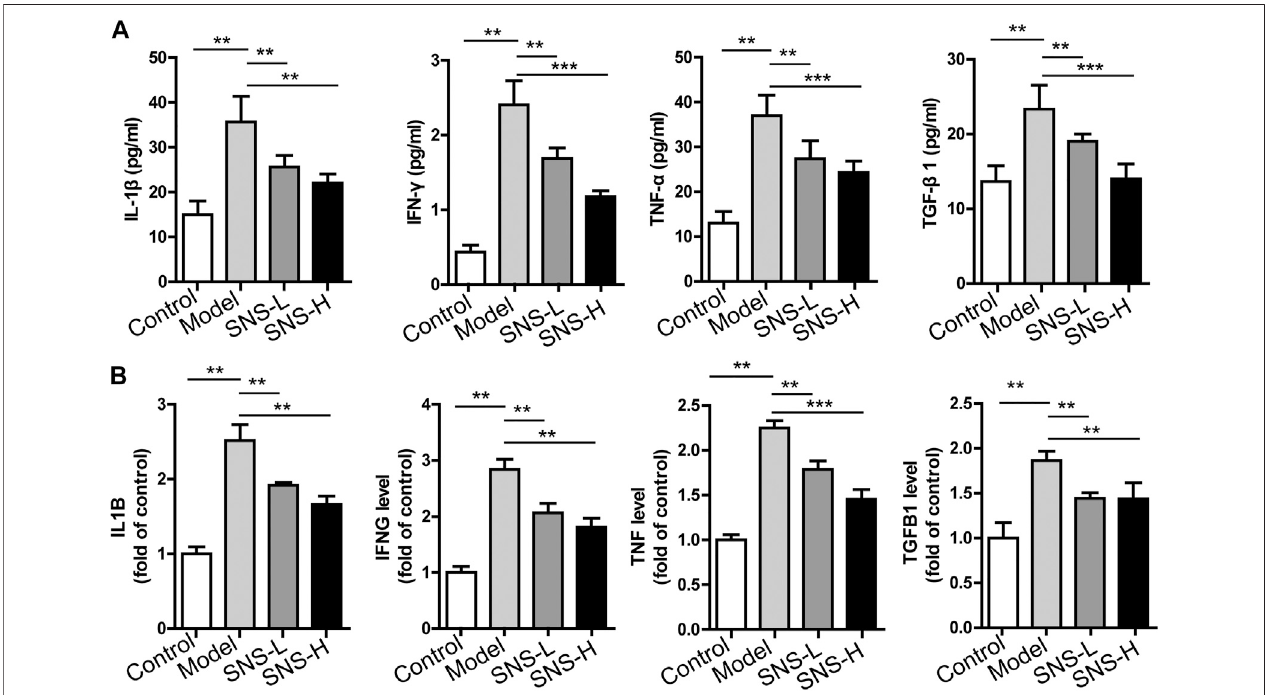
FIGURE 5 | SNS attenuates in fl ammation in mice with liver fi brosis. Liver and serum samples were obtained from control and fi brotic mice administered water or SNS (5 g/kg and 10 g/kg) at the indicated times. (A) Secretion of IL-1 β , IFN- γ , TNF- α and TGF- β 1 in serum. (B) qRT-PCR analysis of f IL-1 β , IFN- γ , TNF- α and TGF- β 1 mRNA in liver using β -actin as the internal reference. Data are presented as mean ± SD ( n (cid:2) 6). * p < 0.05, ** p < 0.01, *** p < 0.001 compared to control or model group.